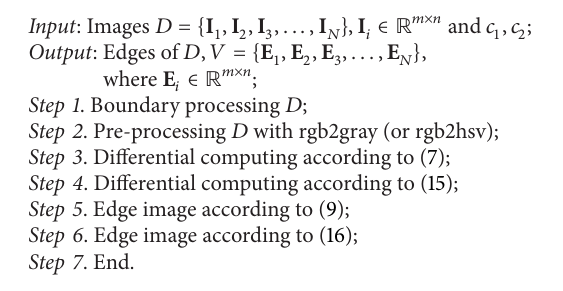
Algorithm 1: Edge Detection with First and Second